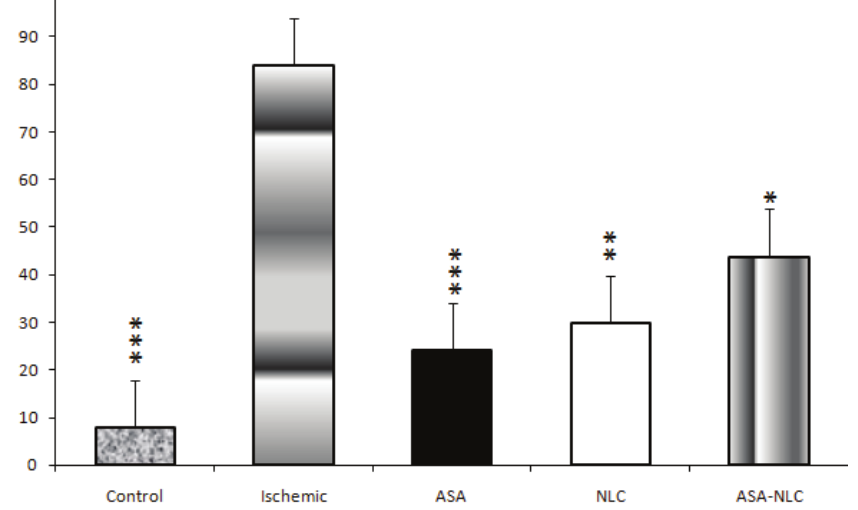
Figure 8: Pancellular Necrosis from the CA1 hippocampus in the different groups. A statistically significant decrease was detected in the proportion of pancellular necrosis in all treatment groups compared with the ischemic group. *, p ≤ 0.05, **, p ≤ 0.01; ***, p ≤